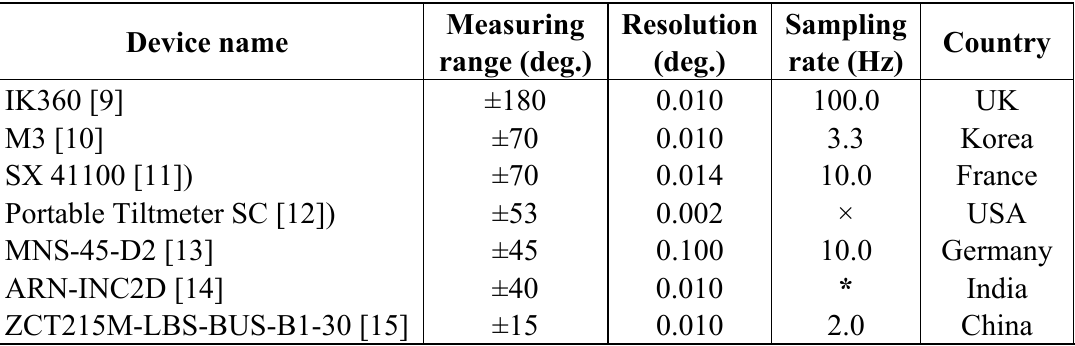
Table 1. Commercial tilt